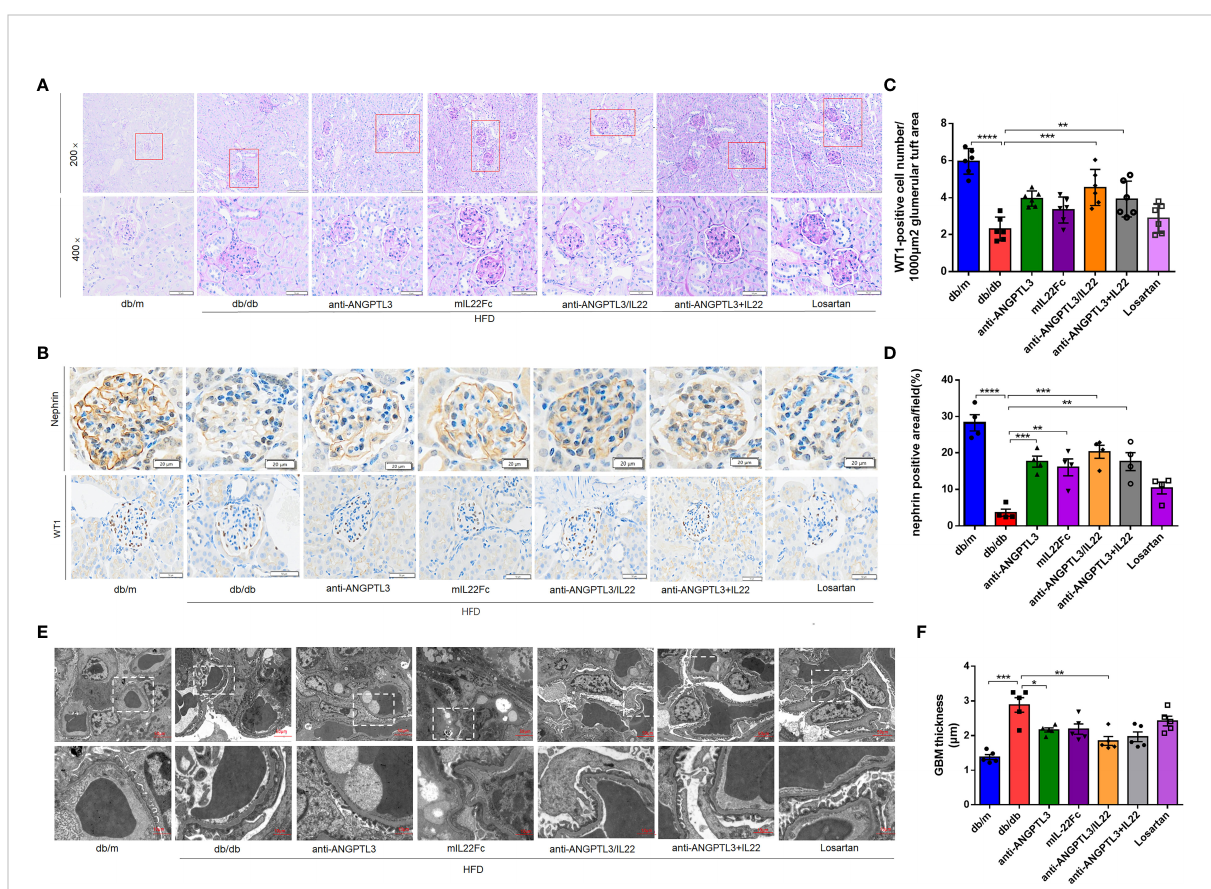
FIGURE 4 Treatment with anti-ANGPTL3/IL22 attenuated histological damage in DN mice (A) Representative images of PAS staining of kidney tissue from db/db mice. (Scale bar: 100 m m, 200 ×; 50 m m, 400 ×). (B) Expressions of nephrin and WT1 were detected by immunohistochemical staining. (Scale bar: 20 m m and 50 m m) (C) Quanti fi cation of WT1-positive cells in the glomerulus. (D) Statistical analysis of nephrin-positive areas in the kidney. (E, F) Representative electron microscopic images in db/db mice and quantitative analysis of glomerular basement membrane (GBM) thickness after the treatment of anti-ANGPTL3/IL22. (Scale bar: 10 m m) (n = 5-7). * P < 0.05; ** P < 0.01; *** P < 0.001; **** P <